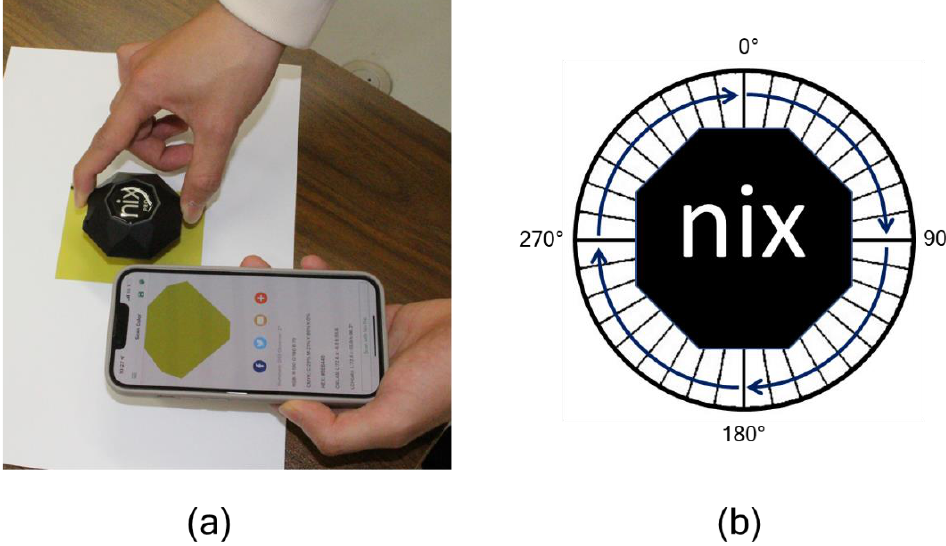
Figure 2. A scene of reading the EBT-XD film using Nix ( a ) with a smartphone application for reading exclusively the data from Nix via Bluetooth. The measurements of the films in a few hours after irradiation with 160 kV X-rays. Angle dependence of measured color intensities was examined by rotation of Nix with 15° intervals in a clockwise direction ( b ).